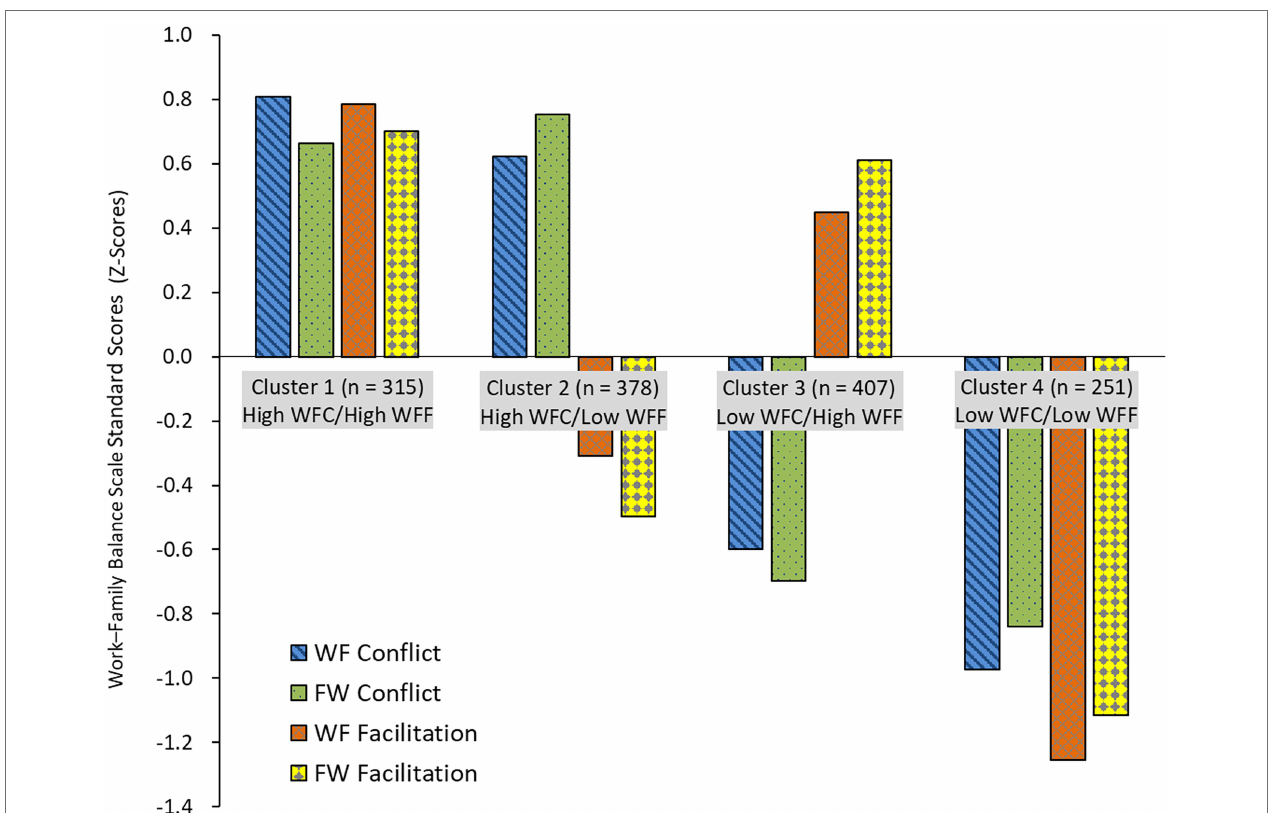
FIGURE 2 | Four clusters and work–family balance scale scores. WFC, Work–Family Conflict; WFF, Work-Family Facilitation; WF Conflict, Work-to-Family Conflict; FW Conflict, Family-to-Work Conflict; WF Facilitation, Work-to-Family Facilitation; and FW Facilitation, Family-to-Work